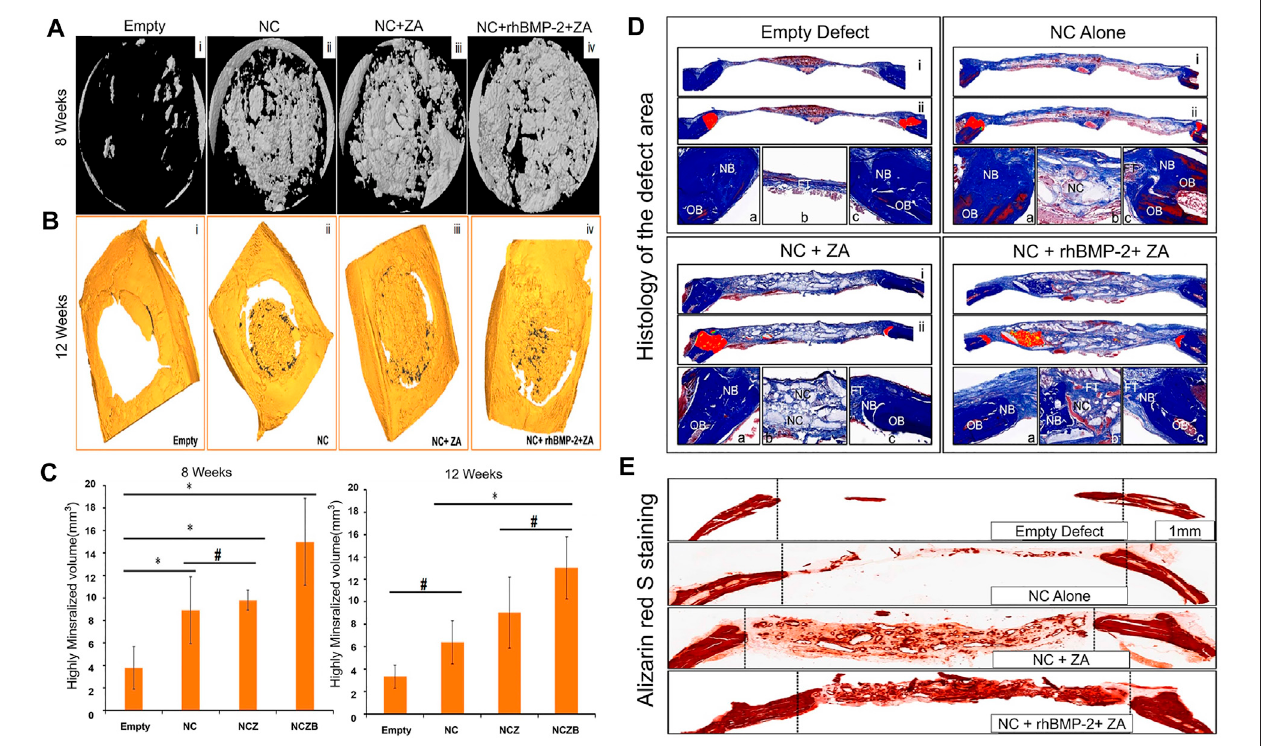
FIGURE5|(A) Micro-CTshowsathree-dimensionalmodelimageofthedefectat8 weeks. (B) Micro-CTshowstheimageofthedefectat12 weeks.Thedefectis highlymineralizedandintegratedwithbonematerial. (C) Morphologicalanalysisofthedefectsitebasedonmicro-CT,showingthehighmineralizationofthedefectsiteat 8 and 12 weeks (* p < 0.05; #no statistical differences between the groups). (D) Histology of the defect area after 12 weeks. Each panel is divided into three sub-panels, where panel (i) (40 ×) represents an overall view, Panel (ii) represents a pseudo-color image, where “ red ” represents new bone (40 ×) from the original defect site. Thebottommostpanelshowsahigh-magni fi cationimage(100×)oftheleftsideofthedefect (a) ,theareainthemiddleofthedefect (b) andtherightsideofthedefect (c) . OB stands for old bone, NB stands for new bone, FT stands for fi ber/connective tissue, and NC stands for nano-cement residue. (E) Alizarin red S staining results are similar to the above results. The NC + rhBMP-2 + Za group had the most alizarin-positive (calcium-speci fi c) mineralized tissues, followed by the NC + Za group. The number of alizarin-positive tissues in the NC group alone was less than in the fi rst two groups. After 12 weeks, alizarin red S staining in the non-decalci fi ed bone defect area showed a typical difference in calcium deposition between the groups (40 ×). Reprinted with permission from (Teotia et al.,